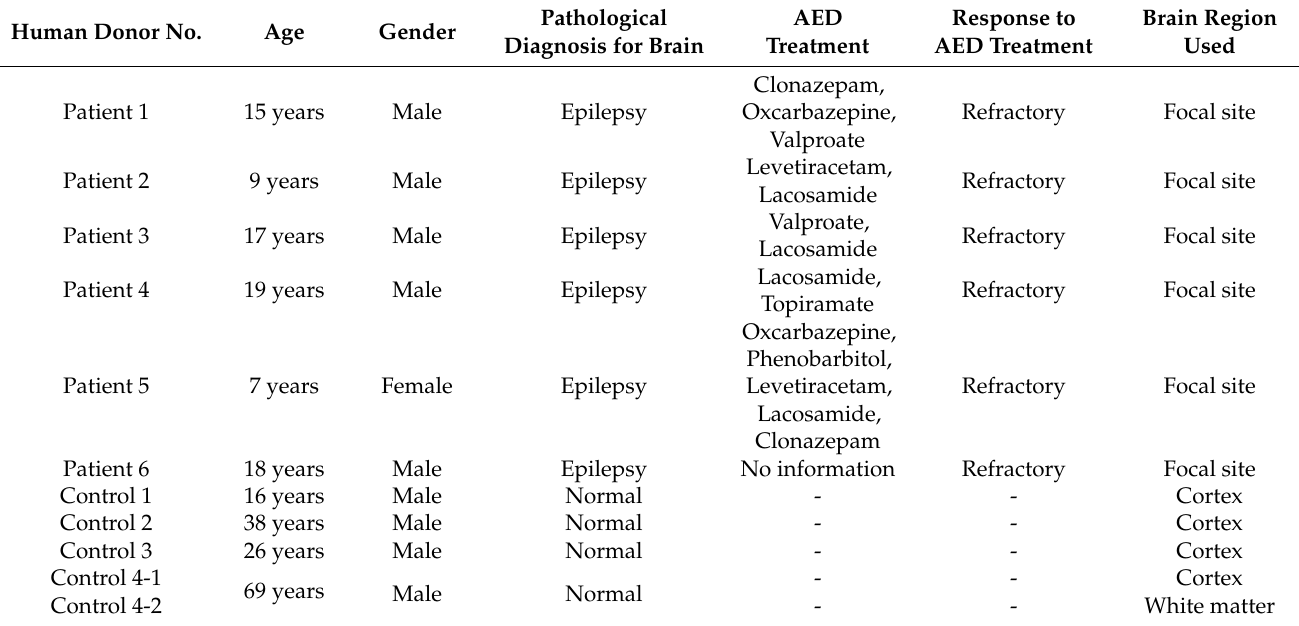
Table 1. Information of brain tissues used for the present